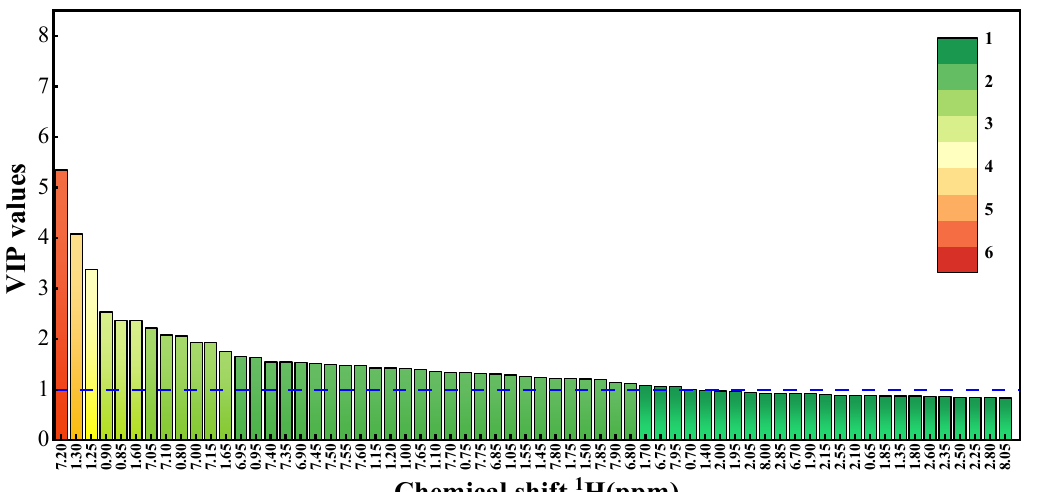
Figure 9. Score chart for OPLS-DA analysis of asphalt samples.